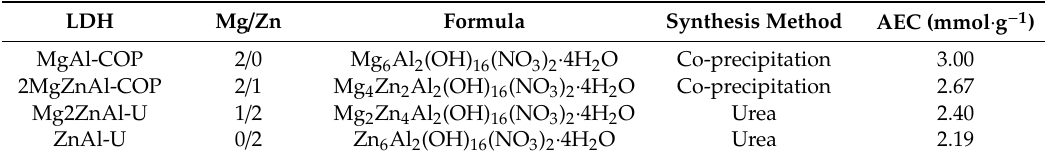
Table 1. Layered Double Hydroxides (LDH) materials.